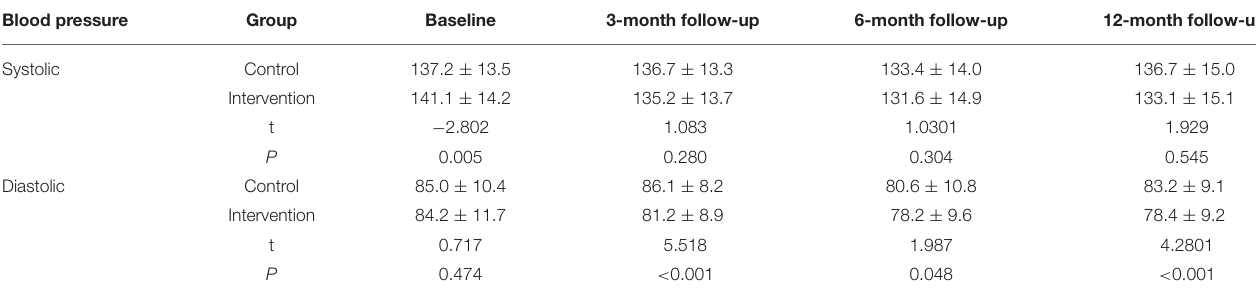
TABLE 3 | Systolic blood pressure and diastolic blood pressure.